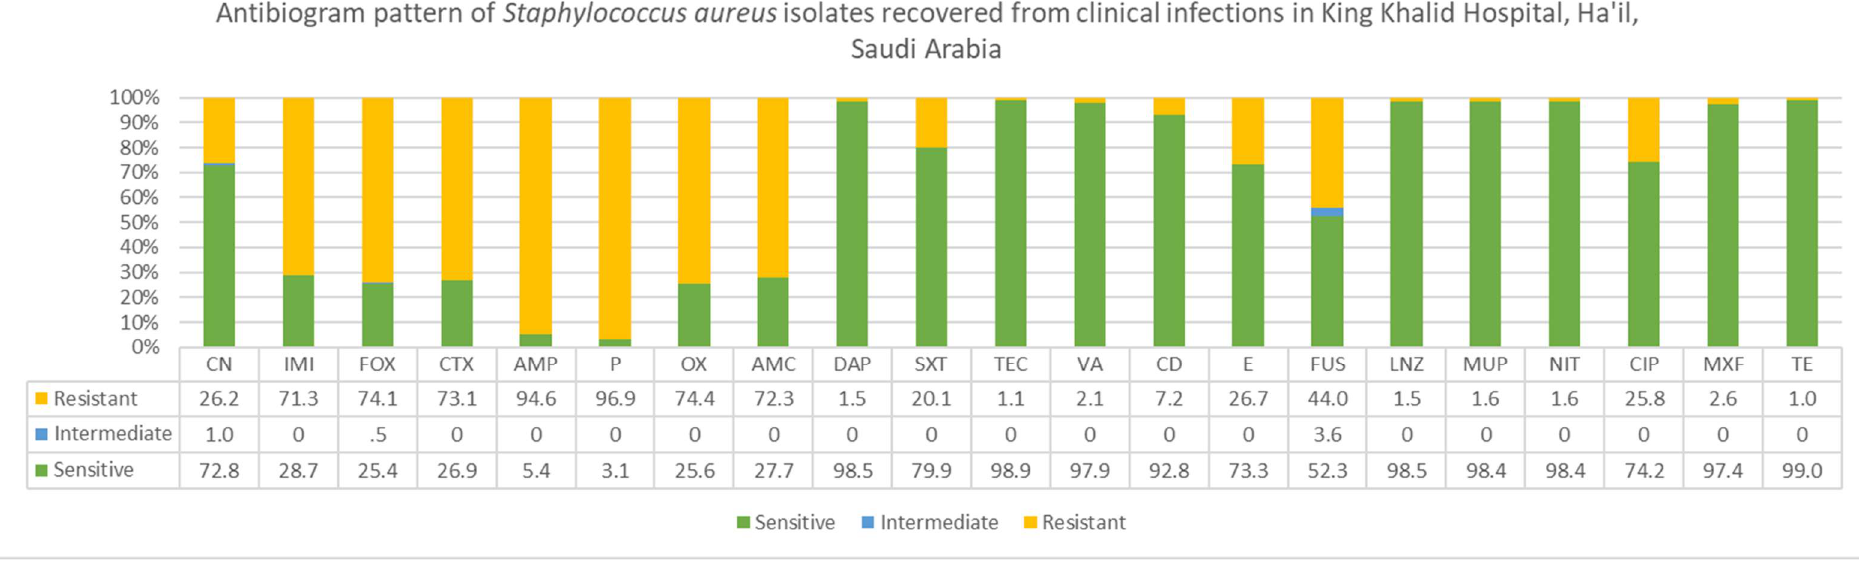
Figure 4. Antibiogram patterns of Staphylococcus aureus isolates recovered from clinical infections in Ha’il regin, Saudi Arabia. Abbreviations of 21 different antimicrobials: CN gentamicin, IMI imipenem, cefoxitin FOX, cefotaxime CTX, AMP ampicillin, p penicillin, OX oxacillin, AMC AMPICILLIN/SULBACTAM, DAP daptomycin, SXT trimethoprim/sulfamethoxazole, TEC teicoplanin, VA vancomycin, CD clindamycin, E erythromycin, FUS fusidic acid, LNZ linezolid, MUP mupirocin, NIT nitrofuran, CIP ciprofloxacin, MXF moxifloxacin, TE tetracycline.